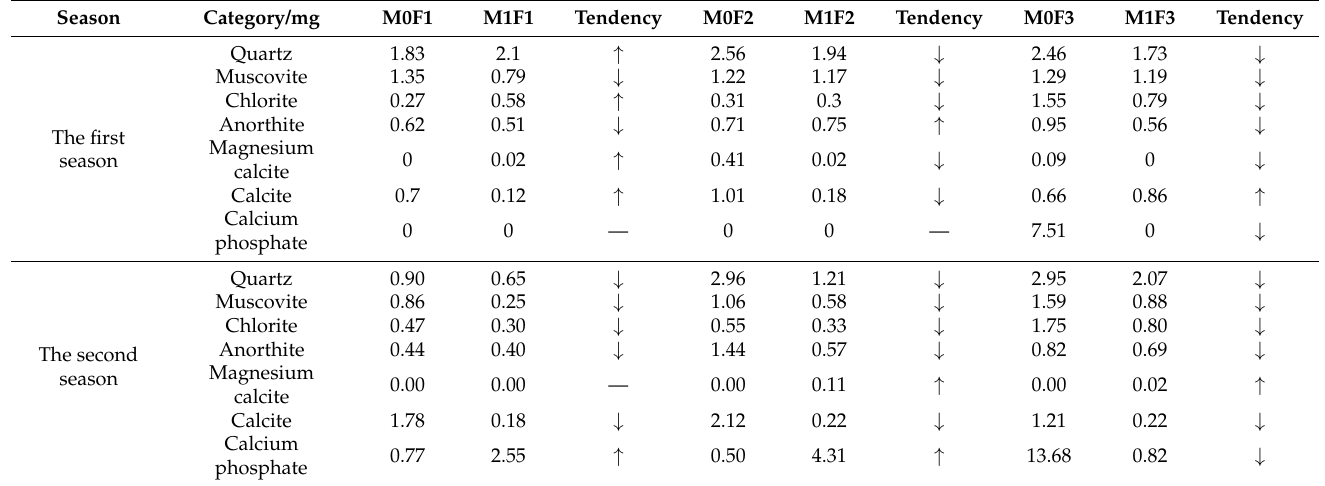
Table 4. Changes of clogging substances in